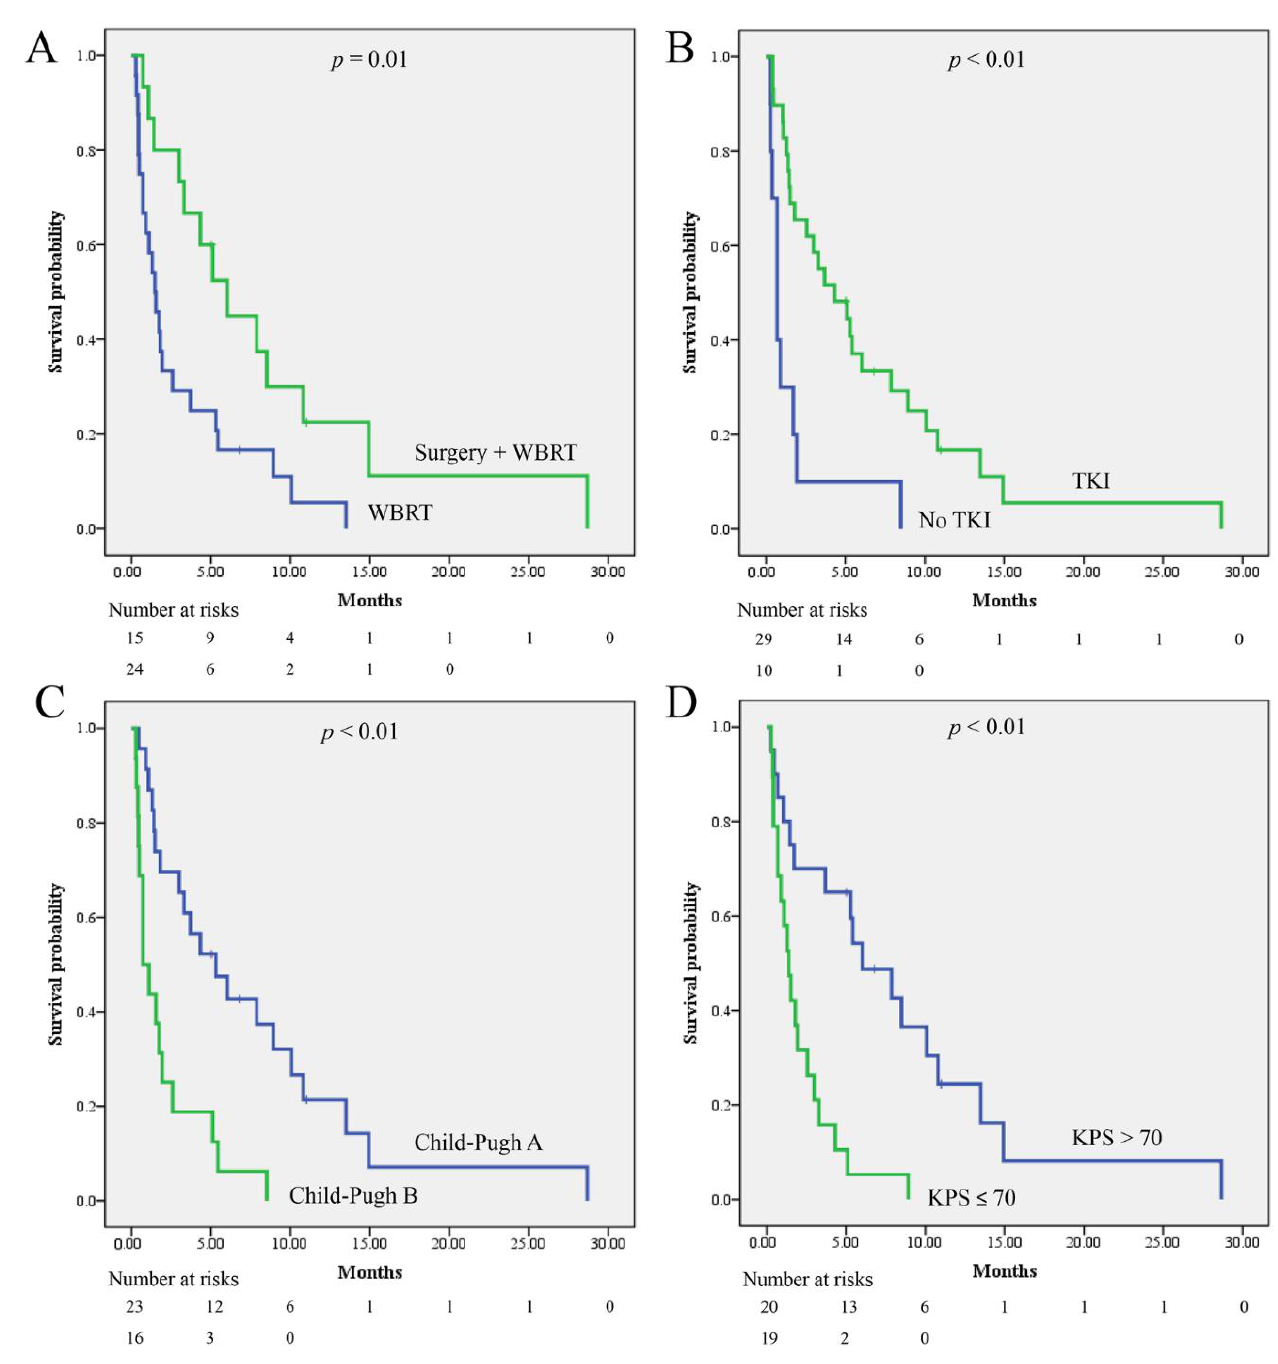
Figure 2. The Kaplan–Meier curves for survival probability were calculated for patients ( A ) having brain metastasis treated with surgery + WBRT or WBRT; ( B ) receiving sorafenib and lenvatinib or not; ( C ) with different Child-Pugh score; ( D ) with different KPS. WBRT: whole-brain radiotherapy; TKI: sorafenib and lenvatinib; KPS: Karnofsky Performance Score.